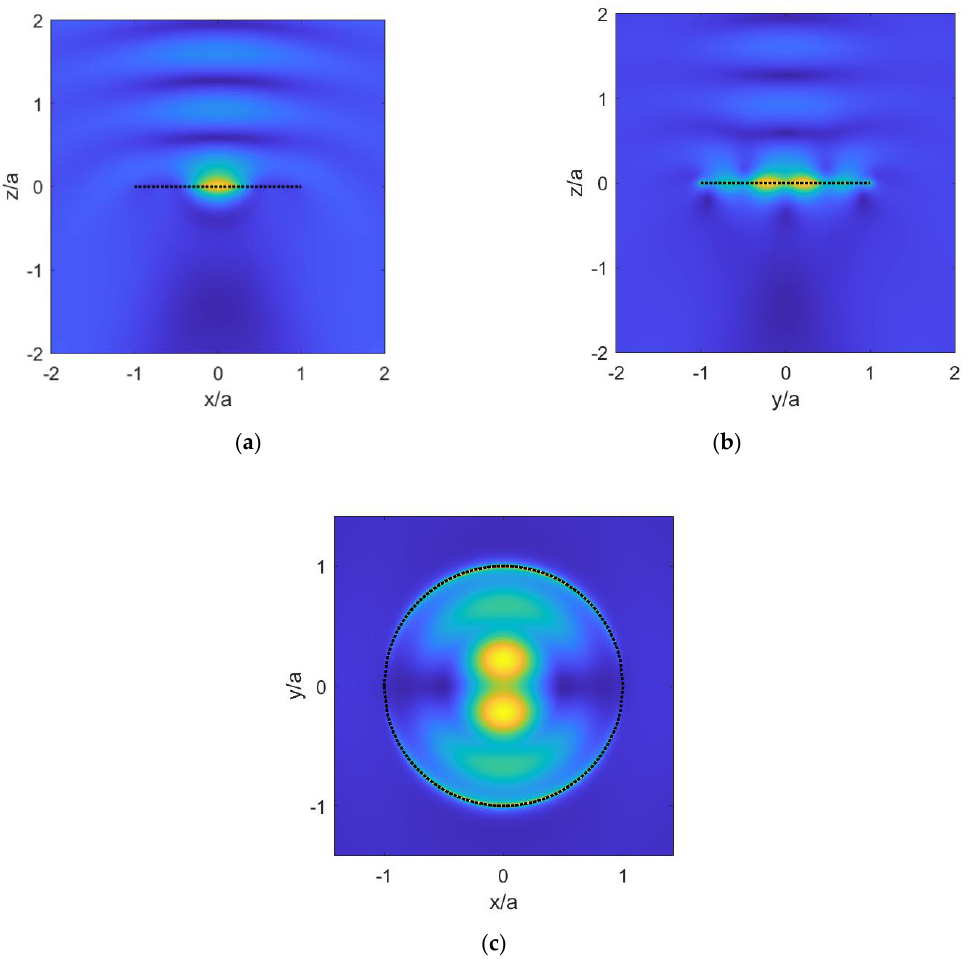
Figure 5. Near E-field behavior in the Cartesian coordinate planes of the graphene disk with a = 50 µ m, T = 300 K, t relax = 1 ps, µ c = 1 eV at the resonance frequency f = 4.637150 THz, when a plane wave orthogonally impinges onto the disk with E 0 = E 0 ˆ y . ( a ) Near E-field in the xz plane; ( b ) Near E-field in the yz plane; ( c ) Near E-field in the xy